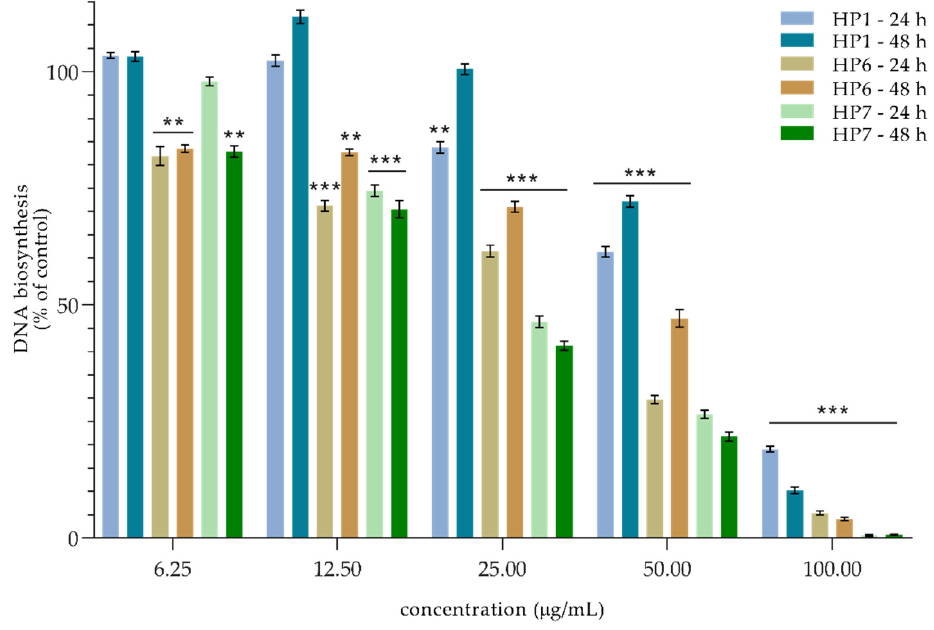
Figure 6. The decreasing effects of HP1 , HP6 , and HP7 extracts (µg/mL) on DNA biosynthesis in SCC-25 cells after 24 h and 48 h of incubation. Mean percentage from at least three independent experiments carried out in duplicate are presented. ** p < 0.01 versus control group, *** p < 0.001 versus control group.